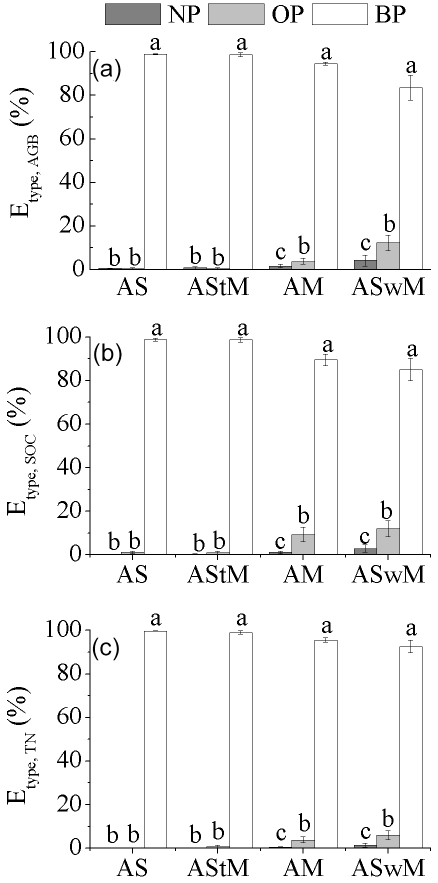
Figure 8. Effects of new pika pile (NP), old pika pile (OP), and bald patch (BP) on reduction of fractional vegetation cover (a) , soil carbon density (SOC) (b) , and total nitrogen (TN) (c) on four types of alpine grasslands (see Fig. 1). Error bar indicates ± standard de- viation and different letters above the error bar indicate significant differences among different surface types ( p